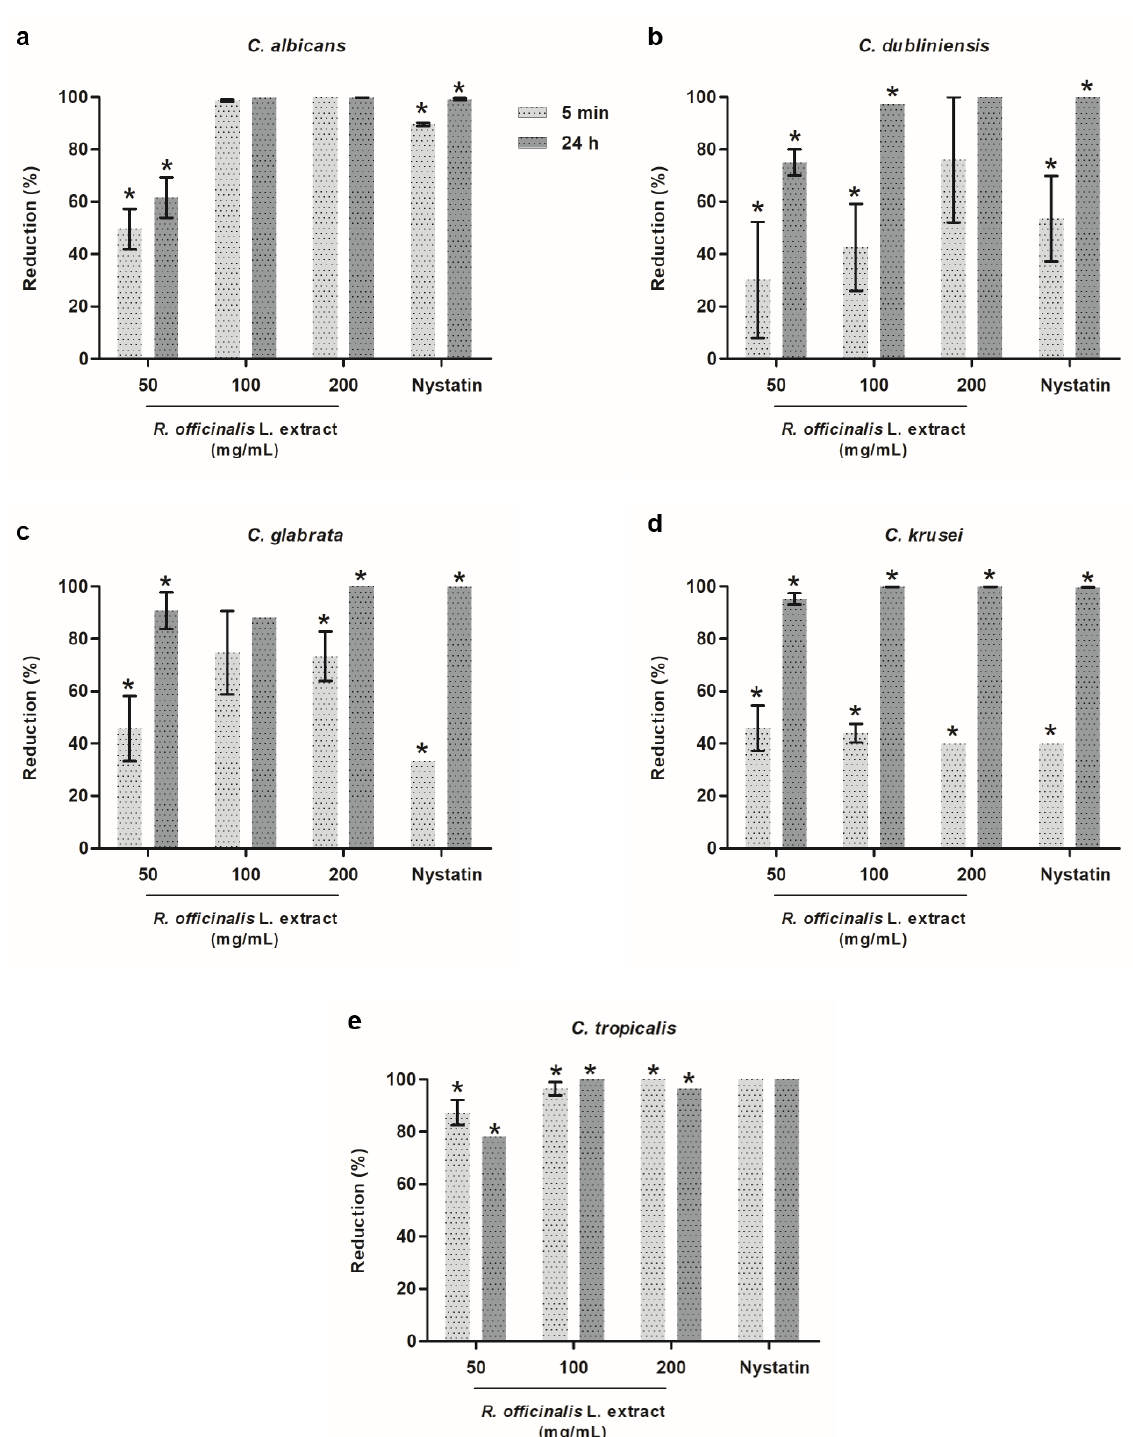
Figure 4. Comparison of mean values (± standard deviation) of reduction percentage of the biofilms of C. albicans (a), C. dubliniensis (b), C. glabrata (c), C. krusei (d), and C. tropicalis (e) between the exposure times of 5 min and 24 h to the R. officinalis L. extract (50, 100, and 200 mg/mL) or to the nystatin (100,000 IU/mL). Asterisks indicate significant statistical difference between the exposure times in each experimental group. ( n = 10; T-test; P ≤